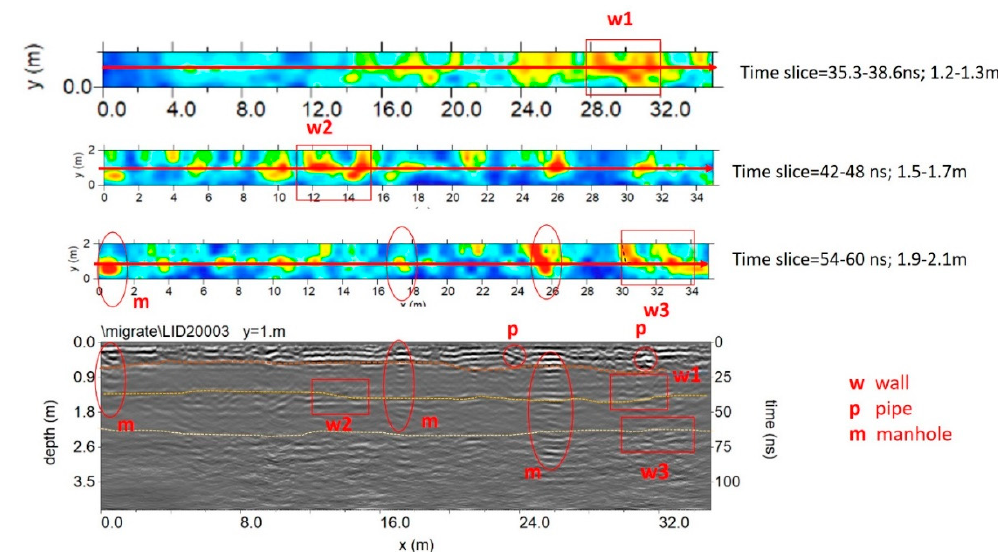
Figure 15. The 200 MHz processed radar section and time slice at 1.2 to 2.0 m exhibit a number of reflectors and high amplitude values considered to be to walls, shallow pipes and manholes.